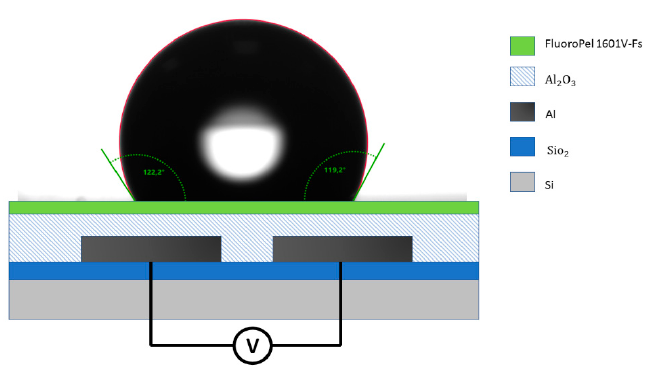
Figure 14. Schematic structure of the actuator system.